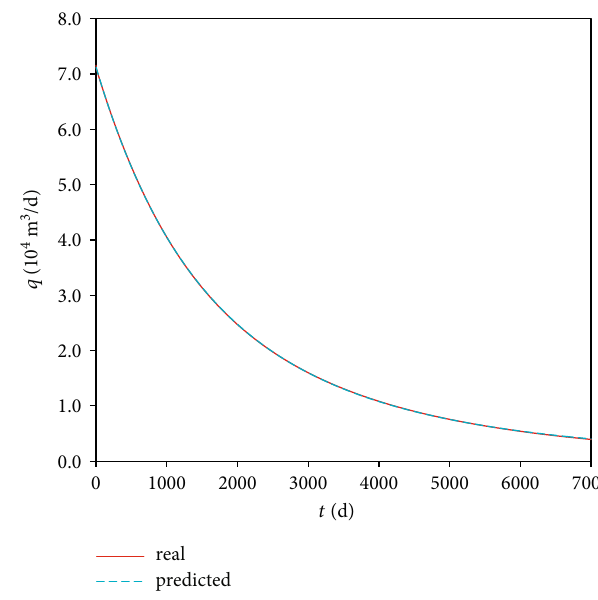
Figure 28: The real q pro fi le and the predicted pro fi le by the hyperbolic decline model for Case 2-4.